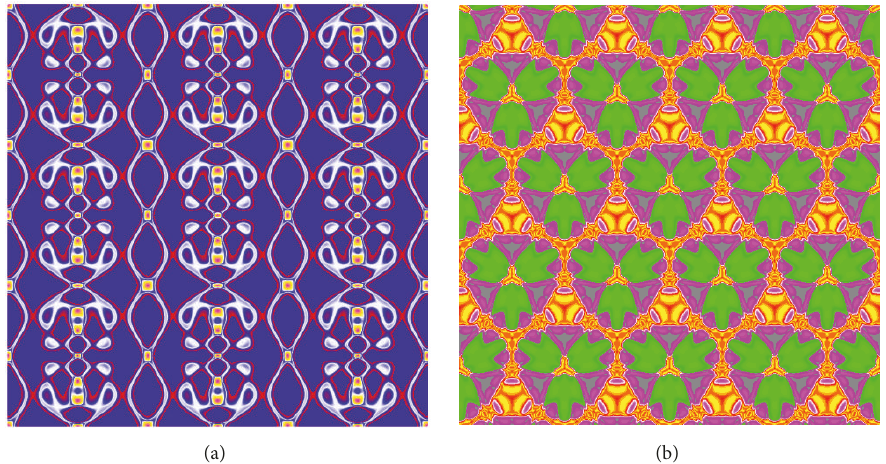
Figure 2: Colorful wallpaper patterns with the 𝑝𝑚𝑚 (a) and 𝑝3𝑚1 (b)